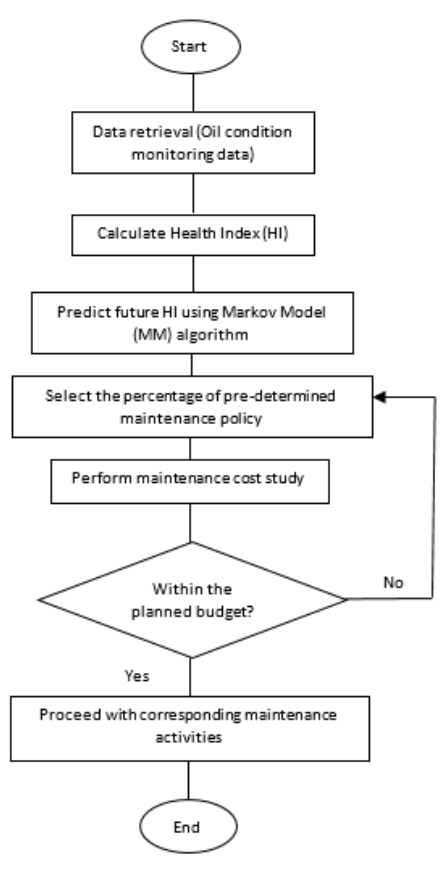
Figure 3. An overall workflow on the maintenance cost study.